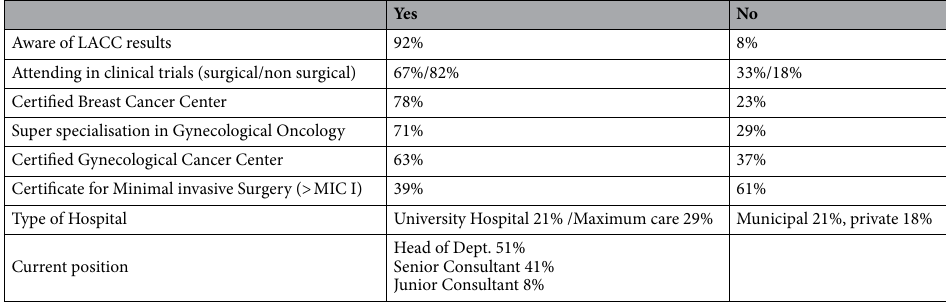
Table 1. Detailed information about the expertise of the participating Centers and Hospitals.